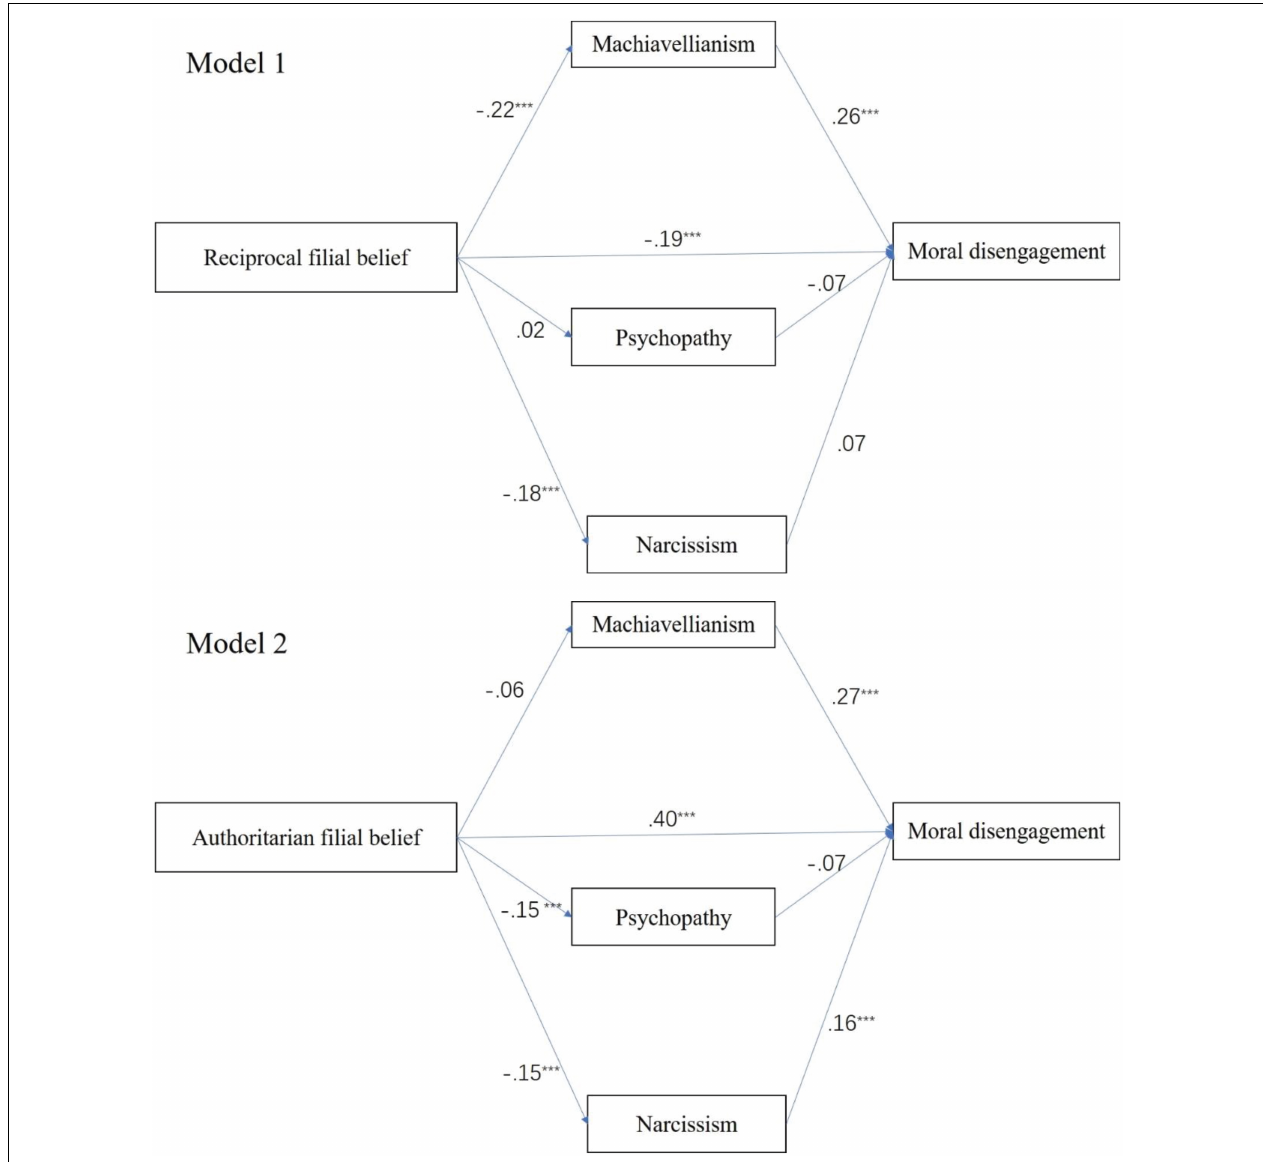
FIGURE 2 | The parallel mediation models of dark triad traits. N = 778, *** p < 0.001; Bootstrap = 5,000.